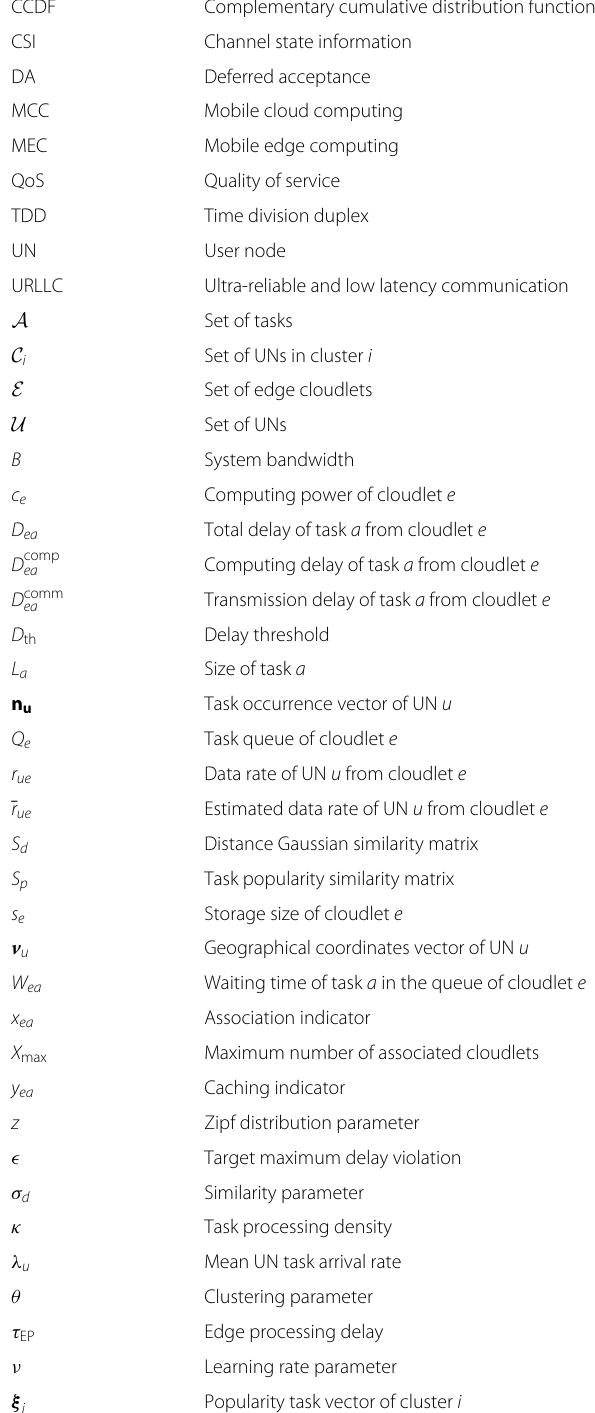
Table 1 List of abbreviations and